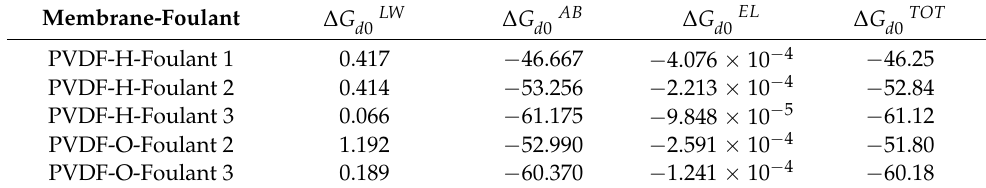
Table 7. Interfacial interaction energy between the foulants and membrane surfaces. (mJ · m − 2